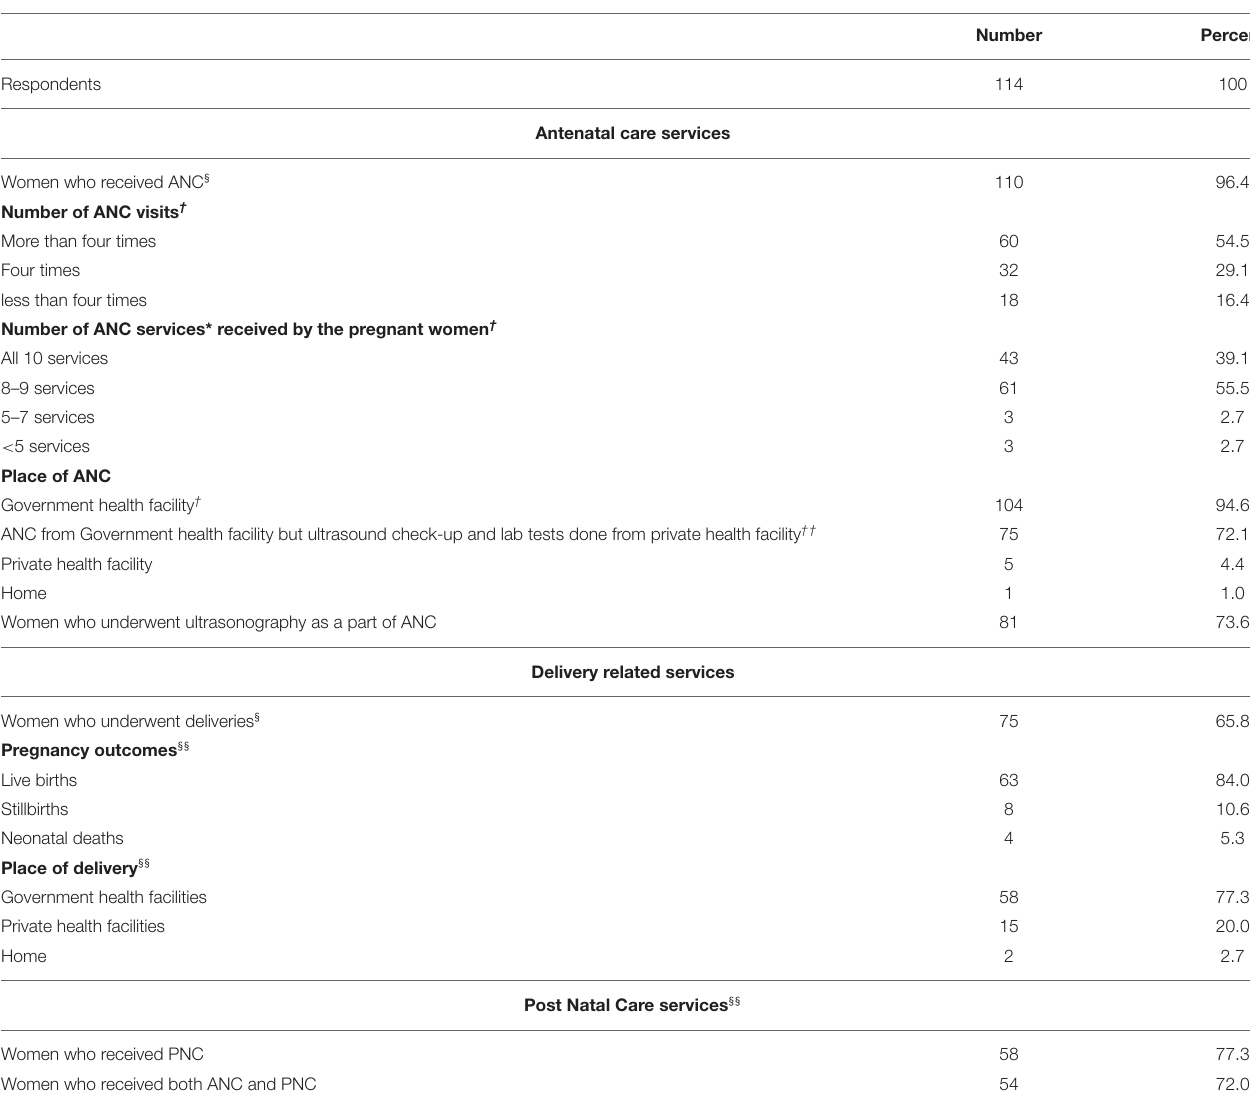
TABLE 1 | Access to ANC, delivery and PNC services for the pregnant and recently delivered